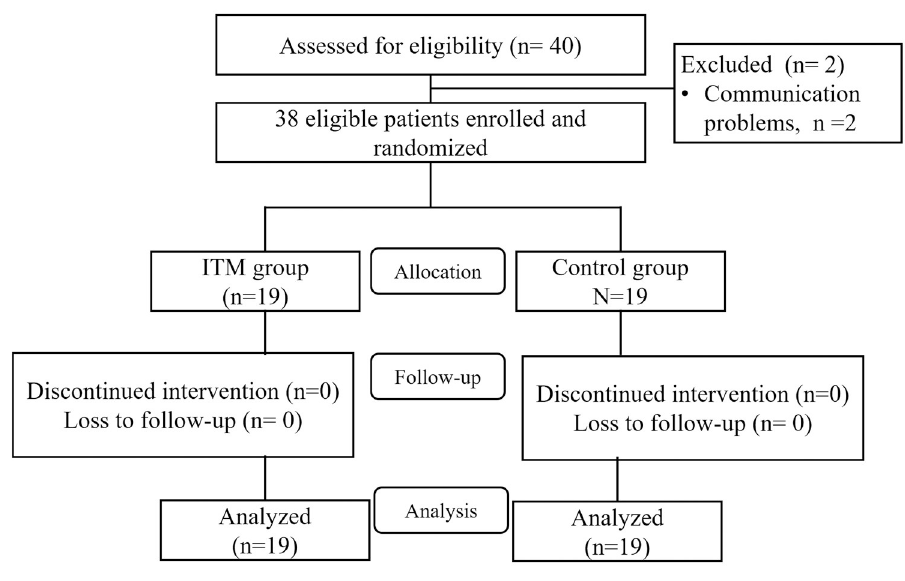
Fig 1. Participant